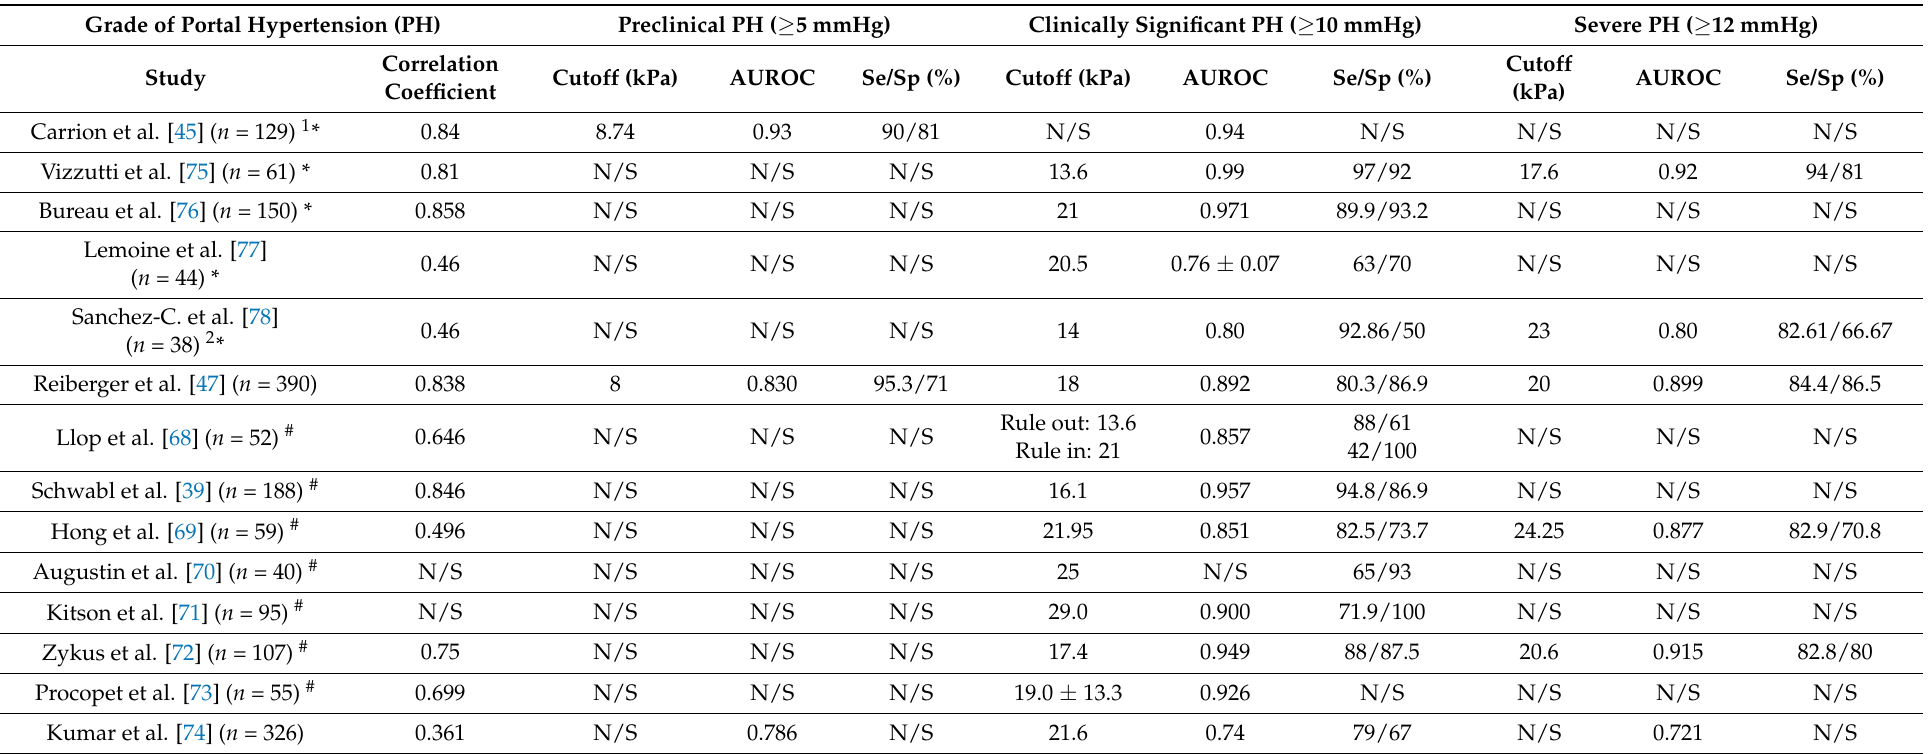
Table 2. Accuracy of LSM for the prediction of preclinical PH, CSPH, and